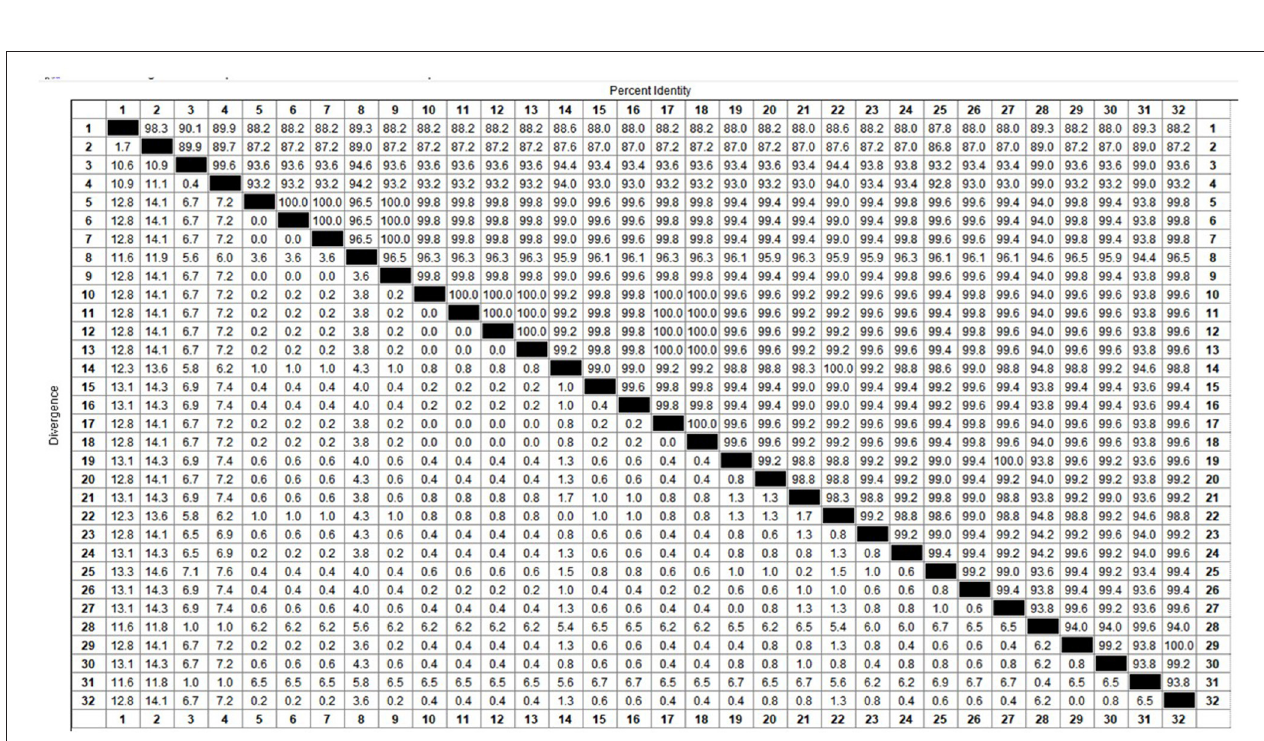
FIGURE 2 | Identity analysis of partial sequences from PCV2 ORF2